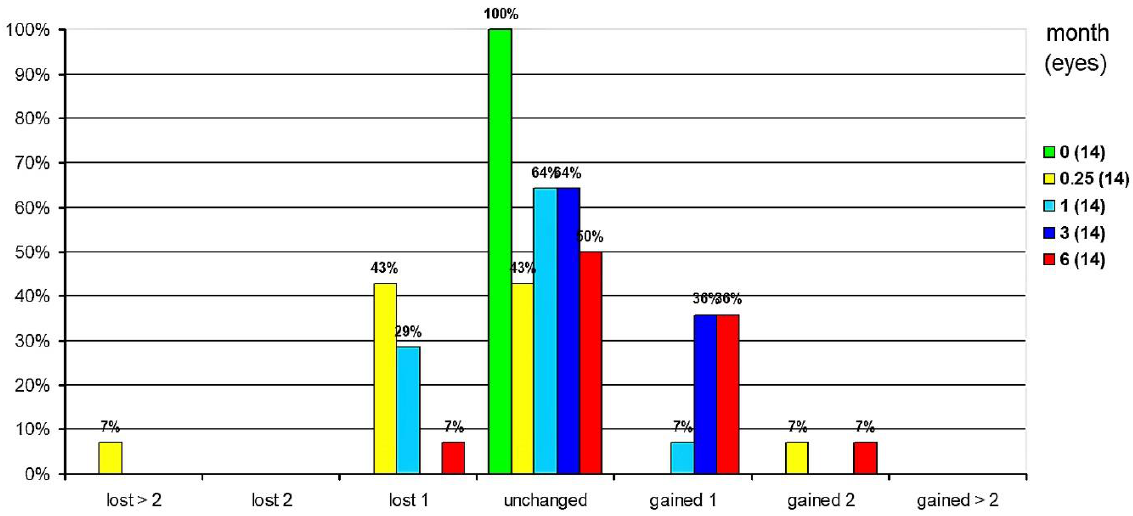
Figure 10. Safety: Changes of corrected distance visual acuity in percentage. The cumulative CDVA at 1 week postoperatively was 0.4 logMAR or worse in 7% of eyes, 0.3 logMAR or better in 93%, 0.2 logMAR or better in 86%, 0.1 logMAR or better in 64%. At 3 months postoperatively, CDVA was already 0.1 logMAR or better in all eyes, and 21% had CDVA of 0 logMAR or better (Figure 11).